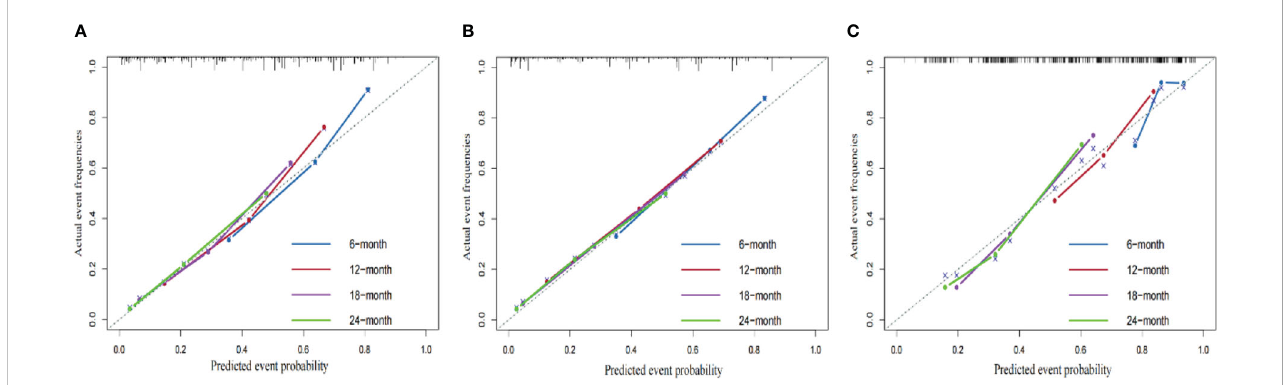
FIGURE 5 The calibration curves of the nomograms using three cohorts show how survival predictions from the model compare to the actual observed survival; the calibration curve of 6-, 12-,18- and 24- months OS for the training cohort (A) , internal validation cohort (B) , external validation cohort (C)